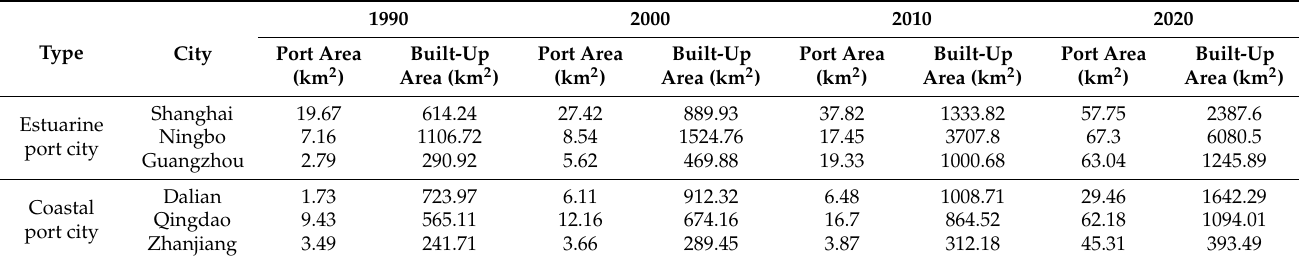
Table 3. Area of estuarine and coastal port